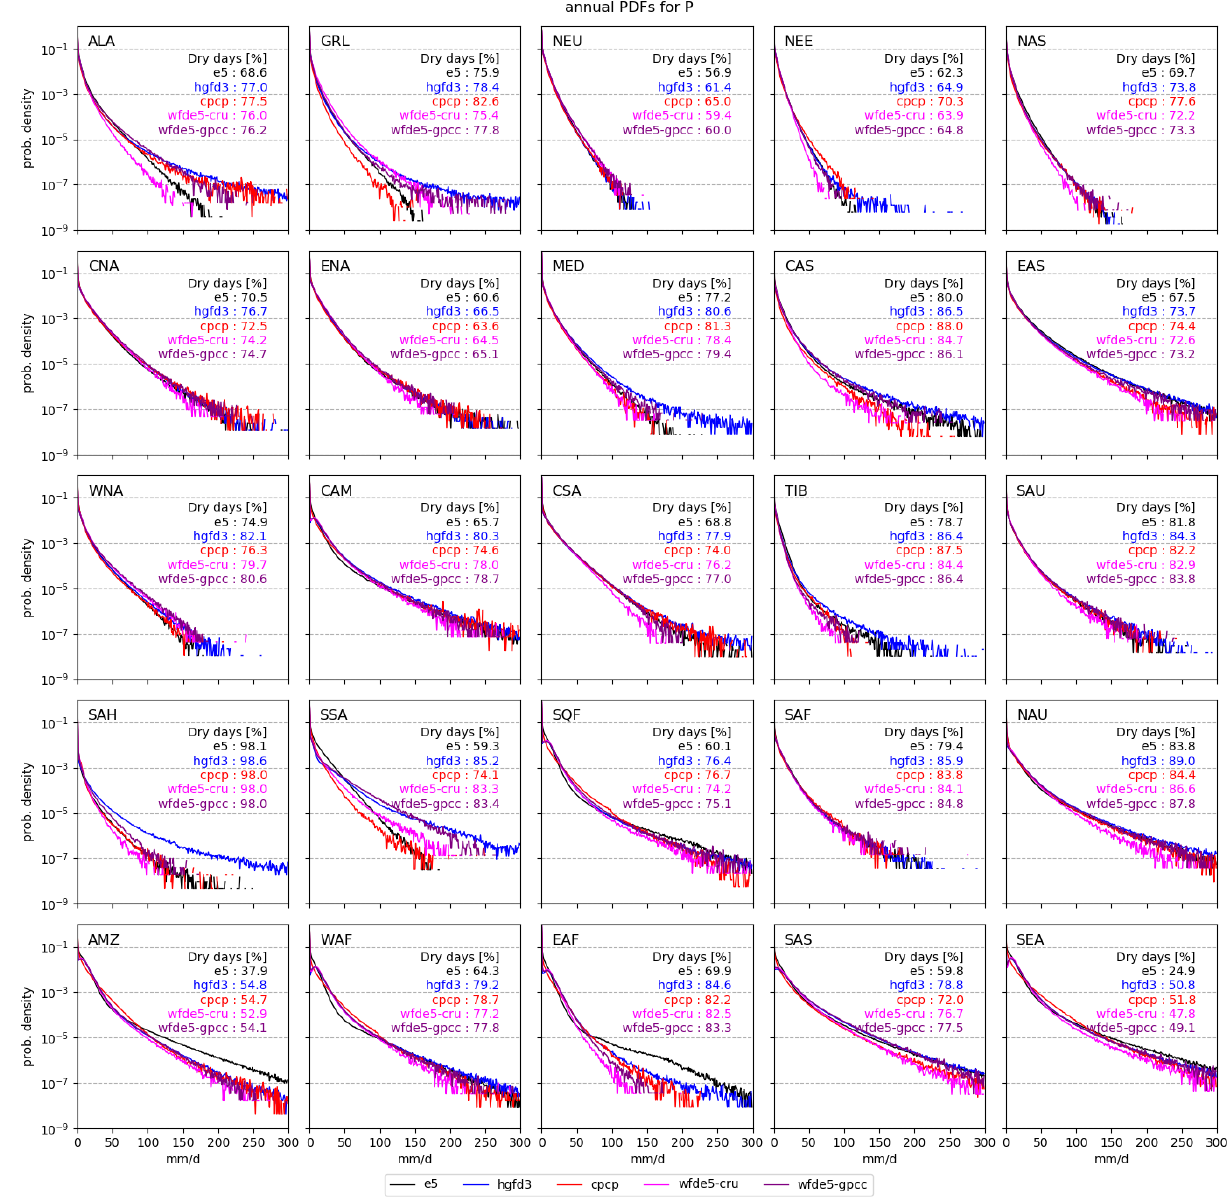
Figure 7. P PDFs of each Giorgi region for the data sets with daily output data in the period 1980–2009. The table in each plot states the percentage of dry days for each data set, i.e. the percentage of data in the first bin of